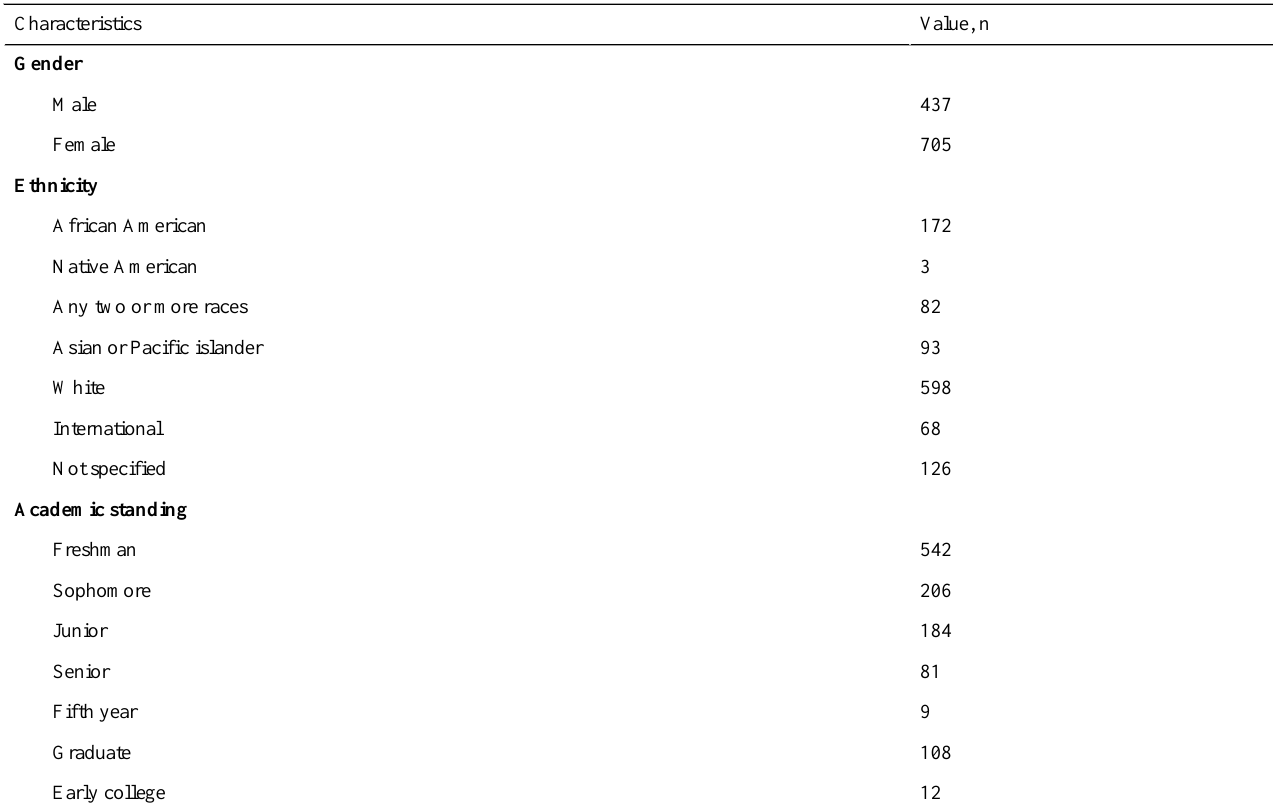
Table 2. Survey respondent demographic data